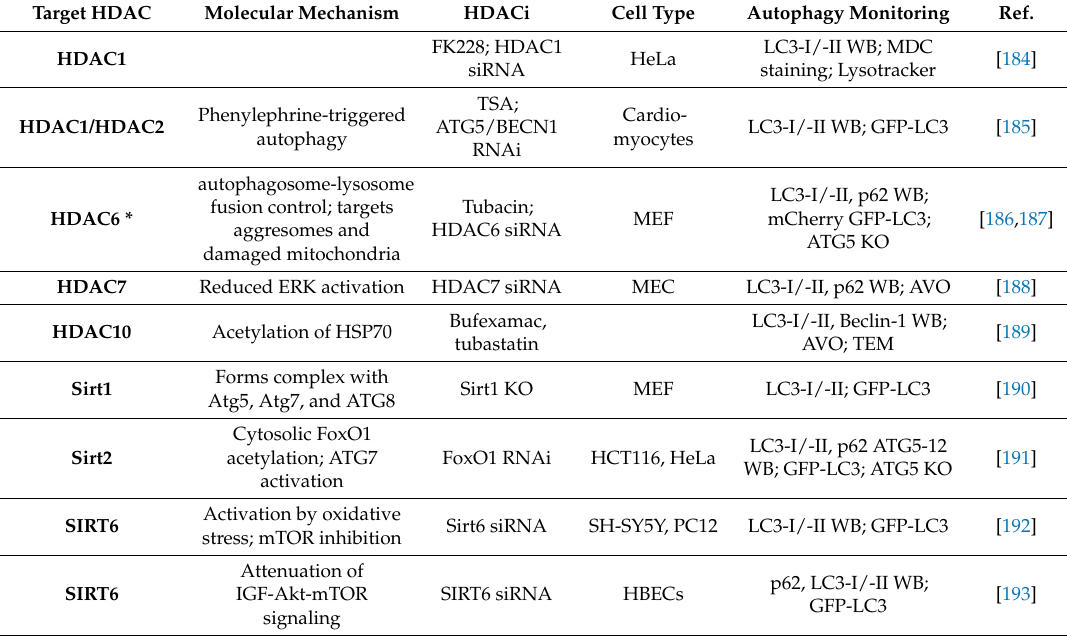
Table 1. The histone deacetylases-triggered autophagic cell